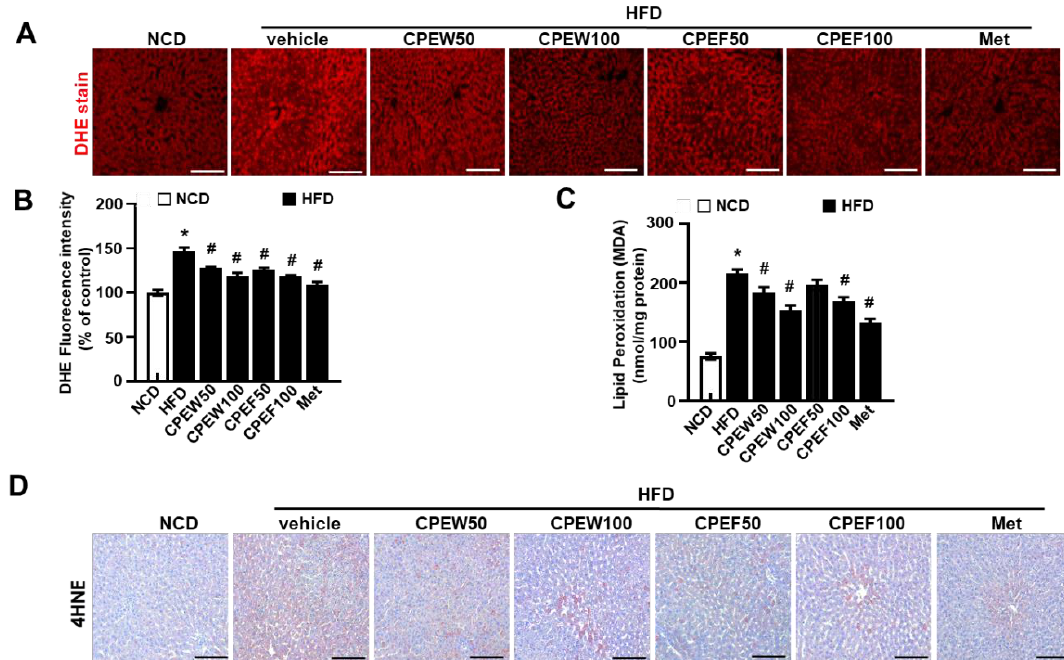
Figure 6. Citrus peel inhibits oxidative stress in hyperlipidemic rats. Rats were placed on either an NCD or 60% HFD for eight weeks and were supplemented with ultra-pure water, metformin (100 mg / kg) or one of the indicated concentrations of citrus peel (50 and 100 mg / kg). In liver tissues, DHE was stained and the fluorescence images were required ( A ) and the fluorescence intensity for superoxide levels was quantified in liver ( B ). In liver lysates, MDA was analyzed ( C ) and in liver section, 4-HNE was stained as described in Materials and Methods ( D ). Values are mean ± SEM. ( n = 7~8, * P < 0.05 vs. NCD-group, # P < 0.05 vs. HFD-group). CPEW, citrus peel extract hot-air dry; CPEF, citrus peel